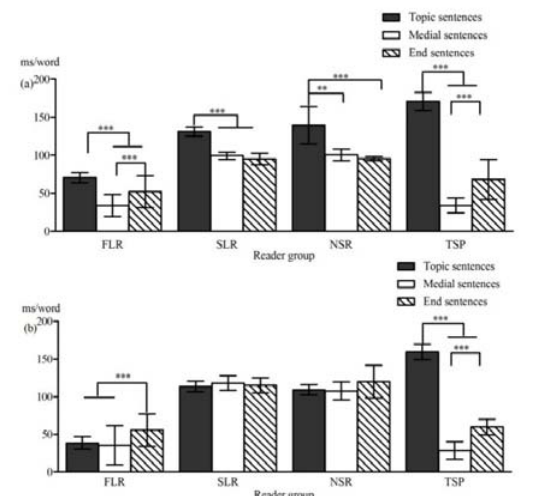
Figure 1. Mean first‐pass reading times (mw/word) of the different reader groups as a function of sentence type under the (a) signalling and (b) no signalling conditions in Experiment 2. ** p < 0.01, *** p < 0.001. FLR = fast linear readers; SLR = slow linear readers; NSR = non‐selective reviewers; TSP = topic structure